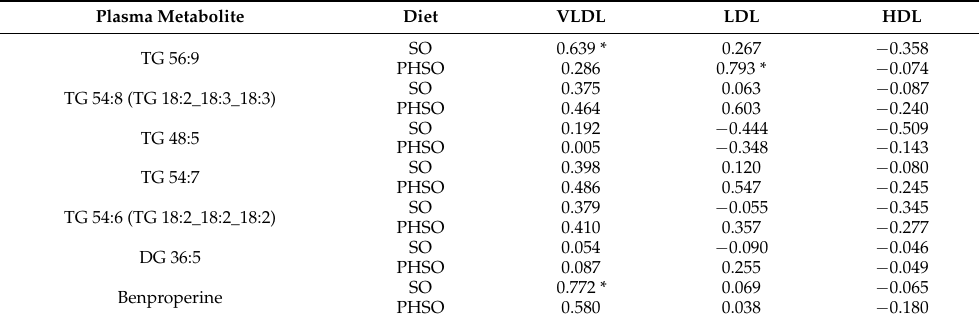
Table 3. Pearson Correlation Coefficient between plasma metabolites and VLDL, LDL and HDL lipoprotein fractions after subjects consumed the SO- and PHSO-enriched